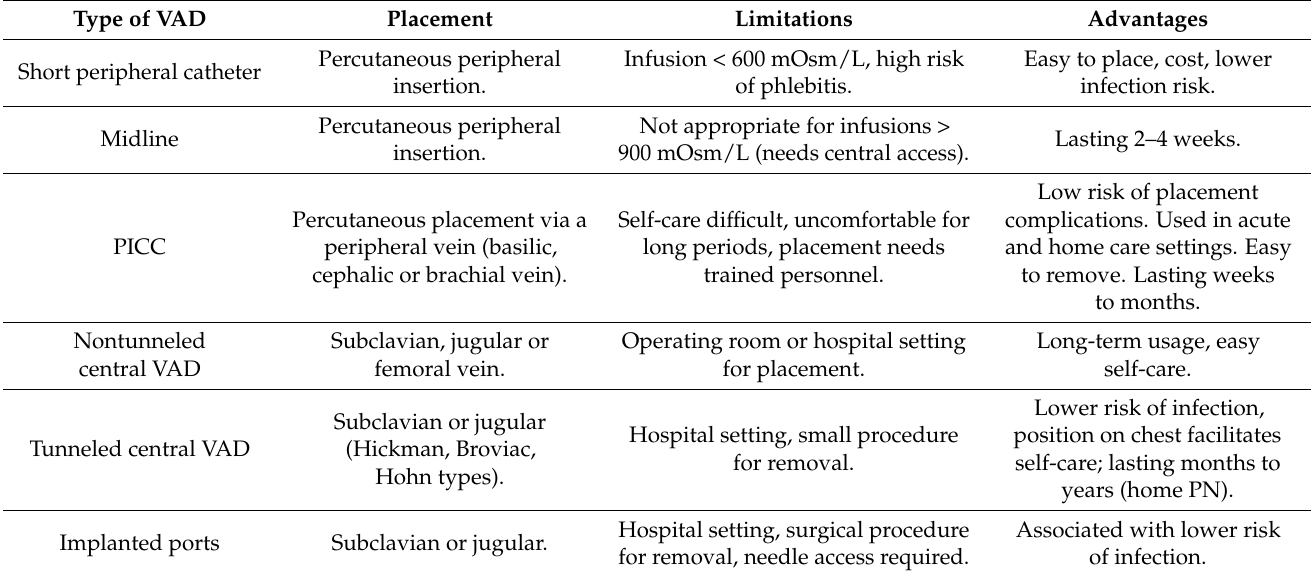
Table 2. Types of VAD used for PN administration